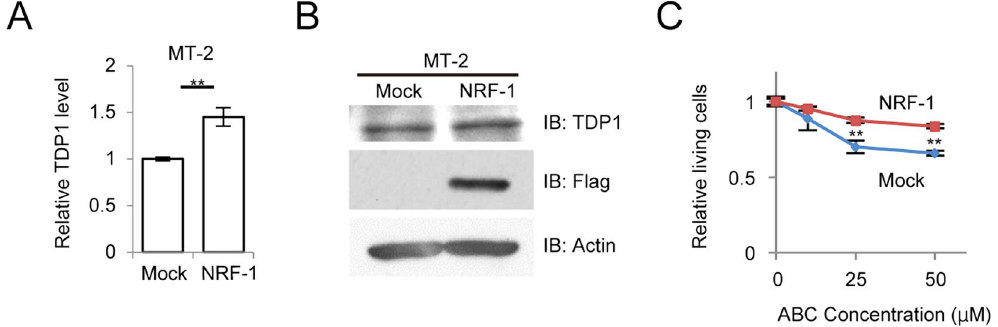
Figure 6. Overexpression of NRF-1 overcomes the inhibitory effect of HBZ on TDP1 expression. ( A ) Quantitative comparison of TDP1 mRNA levels between Flag-NRF-1 ectopic expression and mock in MT-2 cells by real-time PCR. Data shown are the mean ± SD ( n = 3). ( B ) Comparison of TDP1-protein expression between Flag-NRF-1 ectopic expression and mock in MT-2 cells by immunoblotting. ( C ) Viability of the Flag- NRF-1-overexpressed MT-2 cells and control cells after 36 h treatment with the indicated concentration of ABC. MTS values of treated cells relative to untreated cells are shown. Data shown are the mean ± SD ( n =